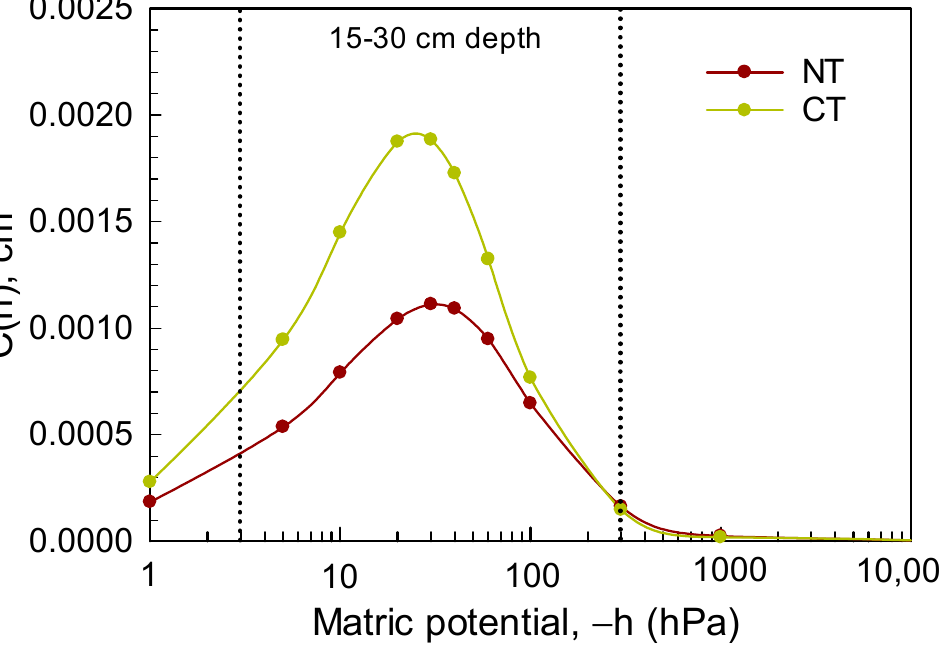
Figure 4. Unimodal pore size distribution showing the slope (C(h)) as a function of matric potential (h) for no-tillage (NT) and conventional tillage (CT) at 15–30 cm soil depth. The dotted lines represent size separation of soil pores.